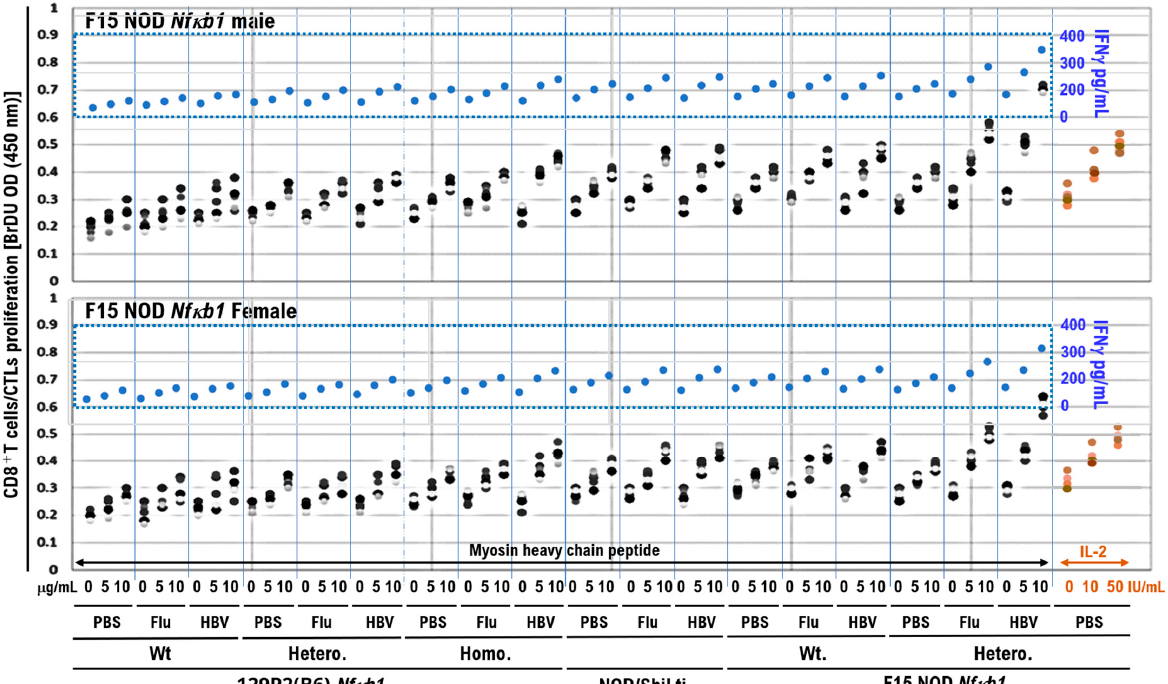
Figure 4. Activation of subpurified CD8 + T-cell proliferation in coculture with Myosin heavy chain peptide. Splenocytes from the mice immunized by intramuscular injection of 50 μ L of influenza HA vaccine, 50 μ L of HBV vaccine (Bimmugen), or PBS were harvested, and red blood cells were removed. CD8 + T-cells were then sorted using a magnetic-activated cell sorting kit (CD8 + T-cell isolation kit II, Miltenyi Biotech) according to the manufacturer’s protocol. The isolated CD8 + T-cells were resuspended in PBS containing 2% FBS. CD8 + T-cells (1 × 10 6 cells/mL) were cocultured with 100 μ L of PBS containing a range of cardiac myosin heavy chain- α amino acids 334–352 peptide (Cosmo Bio Co., Ltd.) at a concentration of 5 or 10 μ g/mL, mouse IL-2 at a concentration of 10 or 50 IU/mL (PeproTech) for 48 h. The cultured cells were harvested and the CD8 + T-cell proliferation was